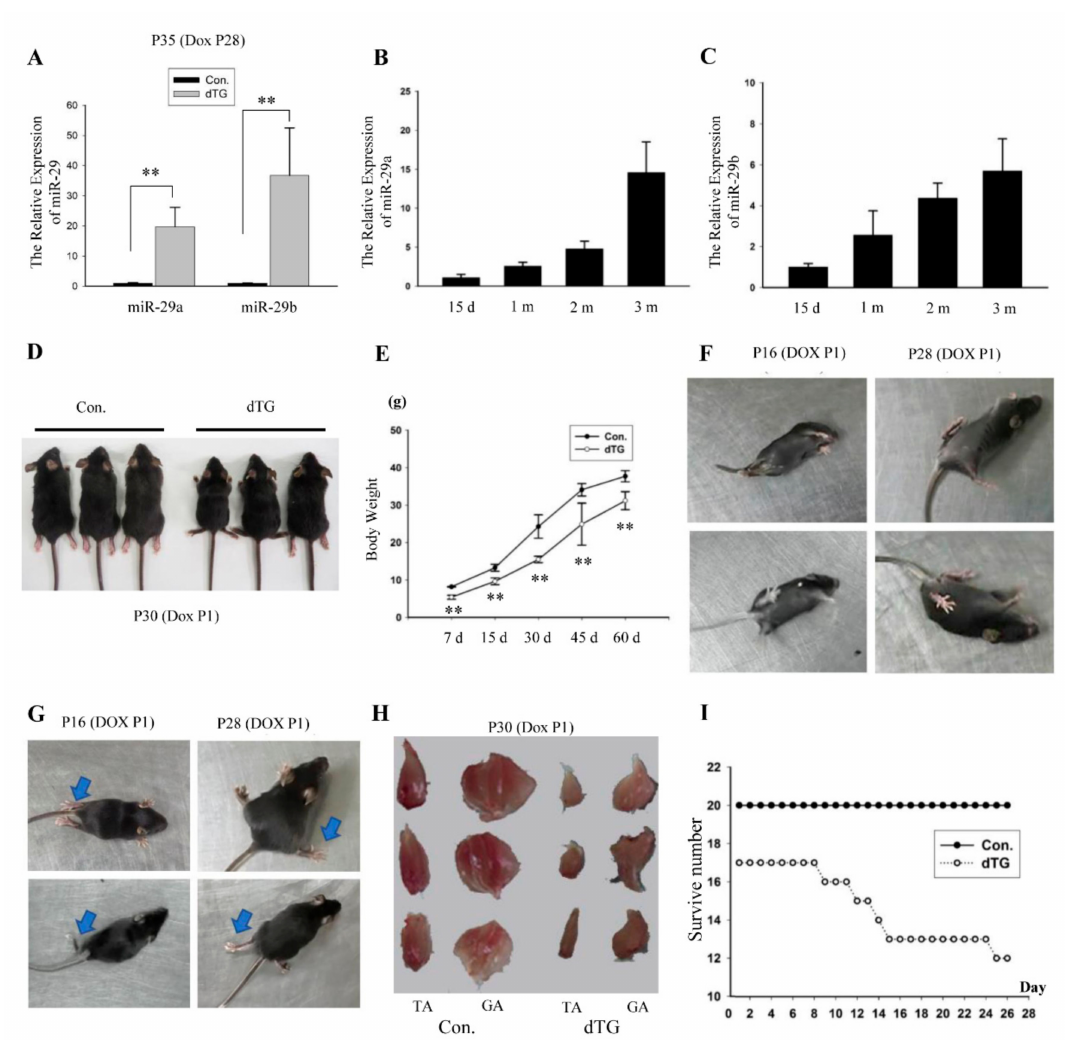
Figure 1. Overexpression of the miR-29a,b1 cluster leads to skeletal muscle dysplasia in juvenile mice. ( A ) Q-PCR analysis of miR-29a, b showing that miR-29a and miR-29b were induced in the tibialis anterior. The dual transgenic (dTG) mice were treated with Dox at P28 (28 day of postnatal development). The tibialis anterior were collected at P35. **, p < 0.01. The values represent the mean ± SEM (n = 3). ( B , C ) Measurement of miR-29a, b in the tibialis anterior muscles in mice at di ff erent ages. d, day(s); m, month(s). ( D ) Size comparison of 30-day-old control and dTG mice. ( E ) Body weight quantification over time; n = 10 for 7 days, n = 6 for other timepoints. **, p < 0.01. ( F , G ) Representative photograph of the dTG mice crawling and turning over. ( H ) Comparison of tibialis anterior muscles and gastrocnemius muscles between control and dTG mice. ( I ) Number of surviving control and dTG mice over time. n = 20 for control mice, n = 17 for dTG